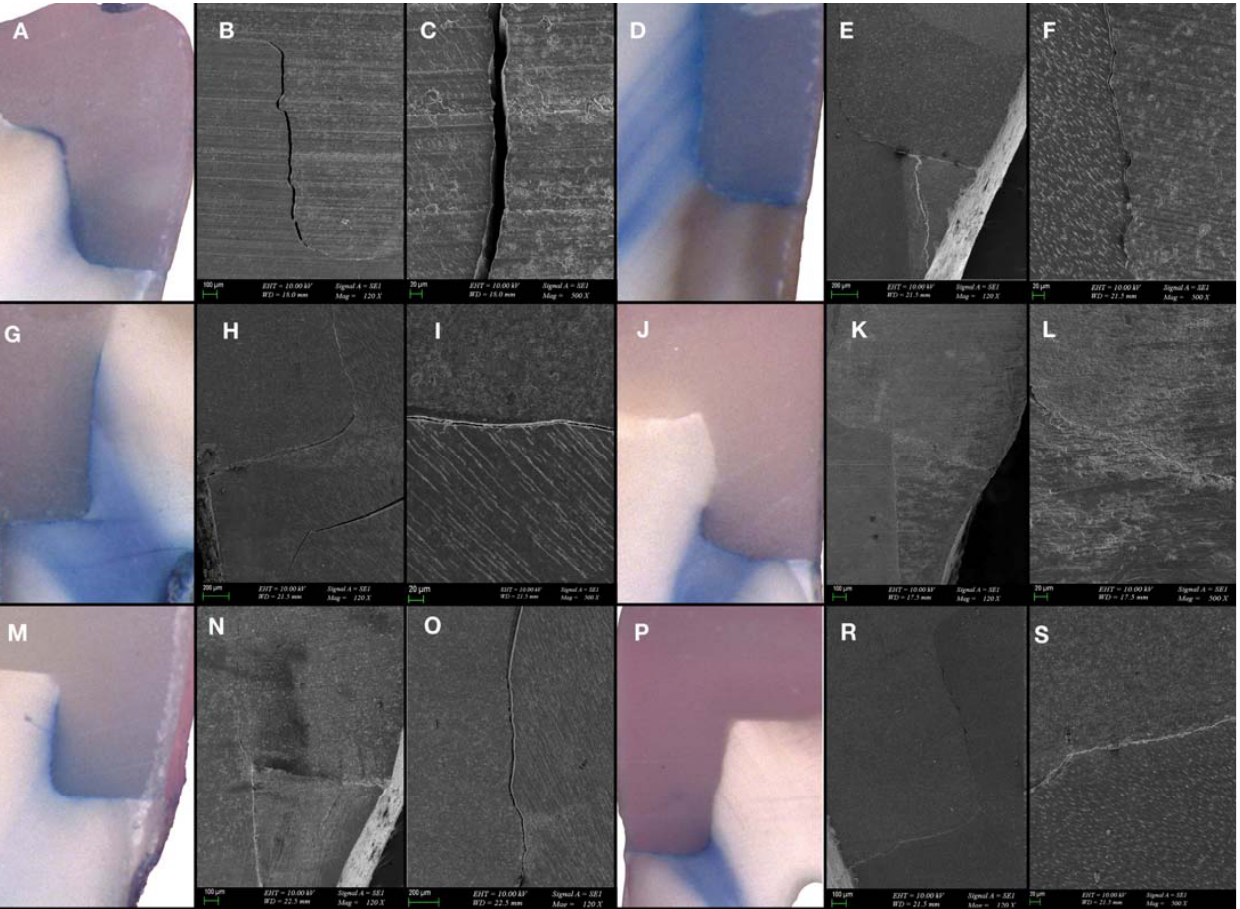
Figure 4. ( A ). Dye penetration of the sample restored with XF2 mm + XB4 mm (G1) (X25); ( B , C ) SEM micrograph of the marginal integrity of XF2 mm + XB4 mm (G1) (X120-X500); ( D ) dye penetration of the sample restored with XF4 mm + XB2 mm (G2) (X25); ( E , F ) SEM micrograph of the marginal integrity of XF4 mm + XB2 mm (G2) (X120-X500); ( G ) dye penetration of the sample restored with TNB2 mm + TFB4 mm (G3) (X25); ( H , I ) SEM micrograph of the marginal integrity of TNB2 mm + TFB4 mm (G3) (X120-X500); ( J ) dye penetration of the sample restored with TNB4 mm + TFB2 mm (G4) (X25); ( K , L ) SEM micrograph of the marginal integrity of TNB4 mm + TFB2 mm (G4) (X120-X500); ( M ) dye penetration of the sample restored with AFX2 mm + AFB4 mm (G5) (X25); ( N , O ) SEM micrograph of the marginal integrity of AFX2 mm + AFB4 mm (G5) (X120); ( P ) dye penetration of the sample restored with AFX4 mm + AFB2 mm (G6) (X25); ( R , S ) SEM micrograph of the marginal integrity of AFX4 mm + AFB2 mm (G6) (X120-X500).